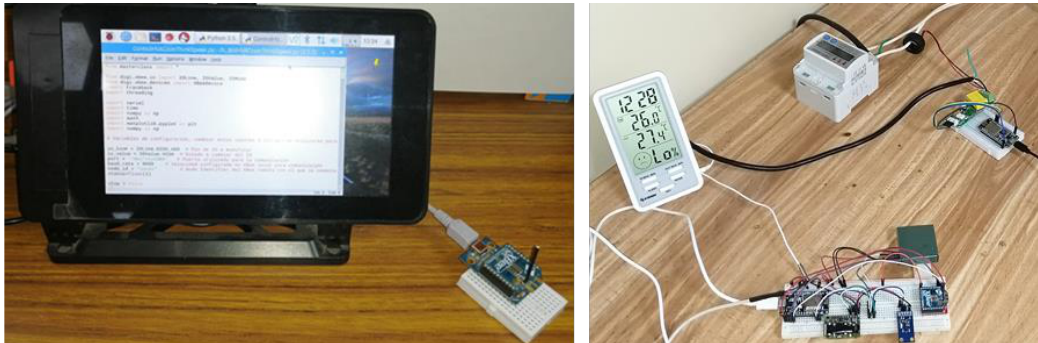
Figure 9. Raspberry Pi, sensor node, and electrical parameter meter .